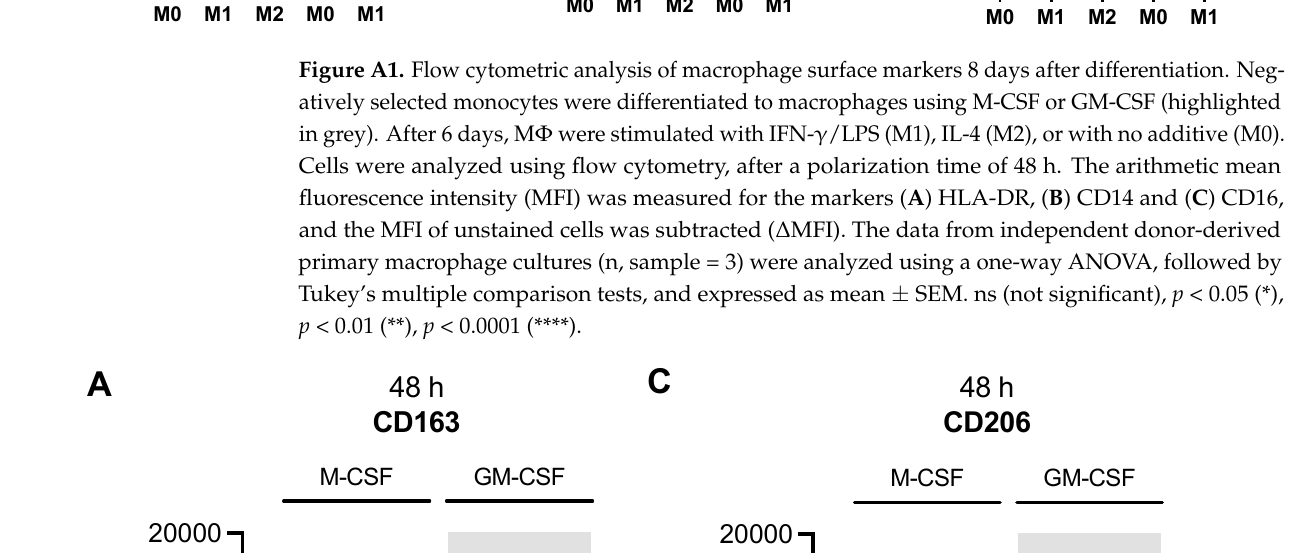
Figure A1. Flow cytometric analysis of macrophage surface markers 8 days after differentiation. Neg-